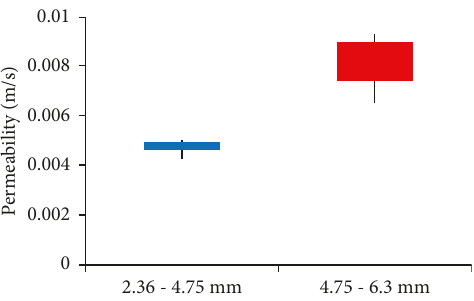
Figure 6: Comparison of porosity with literature.